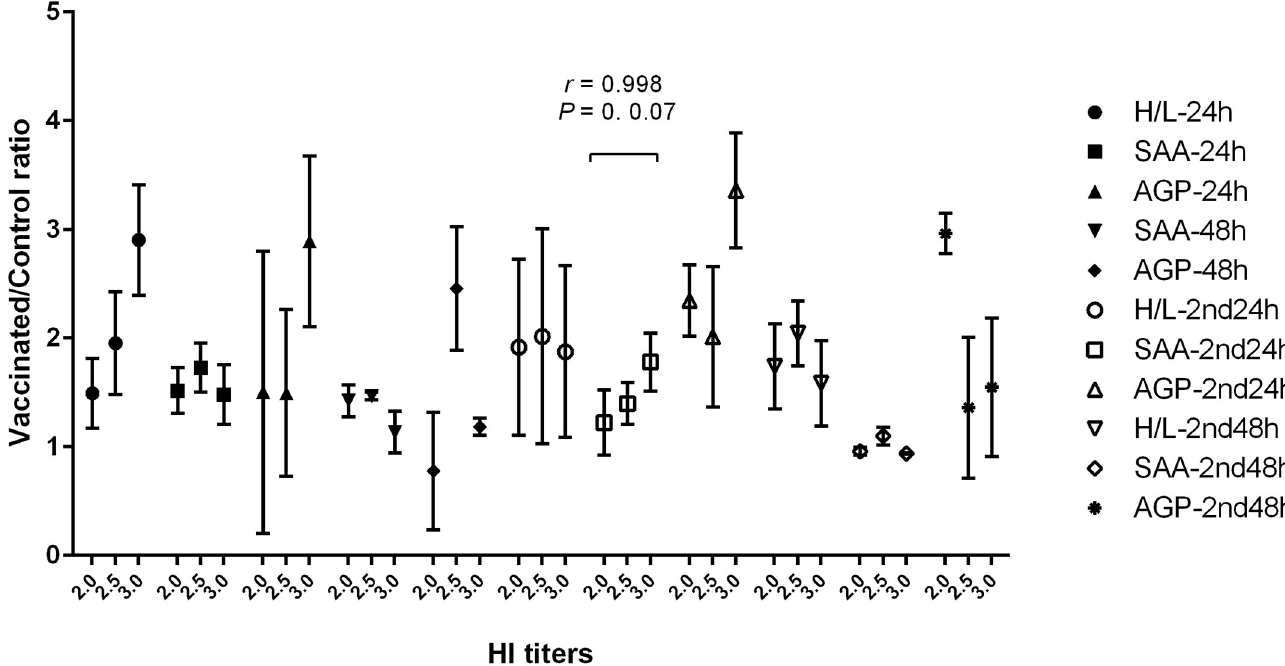
Fig 3. Correlations between HI titers and the H/L or APPs values. All data were expressed as ratio (ratio of the vaccinated to control groups). The results show a strong positive correlation between HI titers and SAA values after second vaccination (SAA-2nd24h).